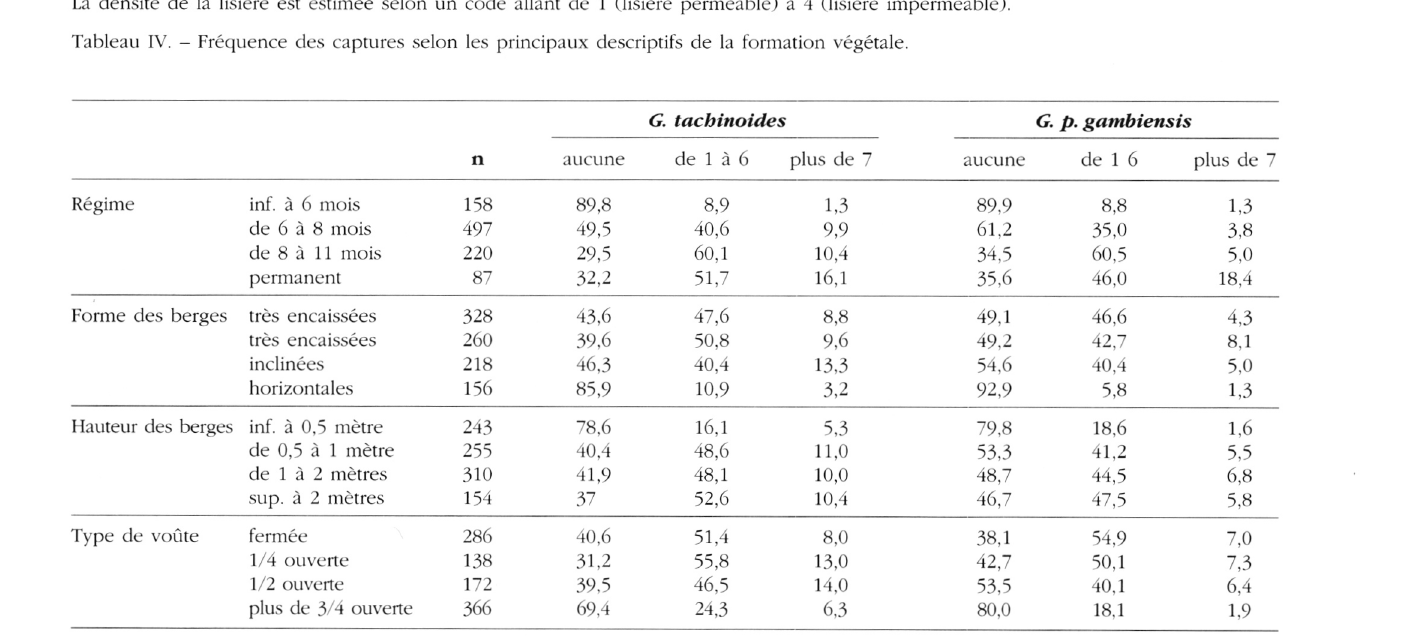
Tableau V. - Fréquence des captures selon les principaux descriptifs du cours d’eau.